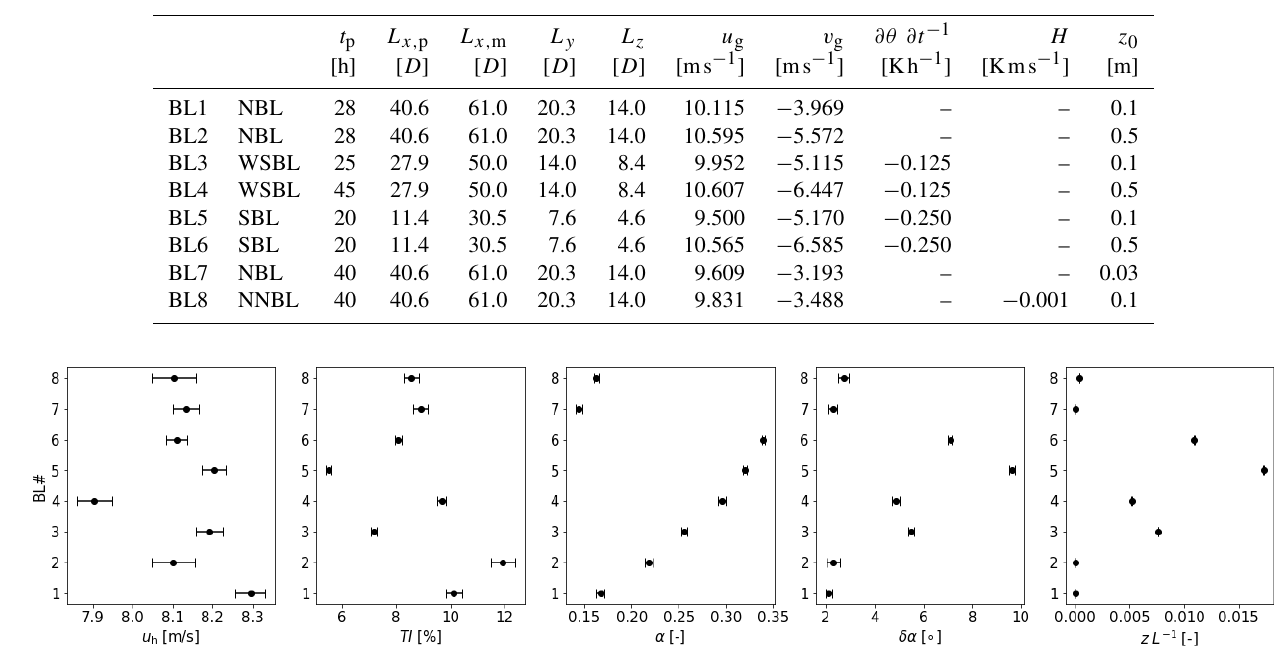
Table 1. Summary of simulation parameters and classification into neutral (NBL), near-neutral (NNBL), weakly stable (WSBL) and stable (SBL) boundary layers. The size ( L x, p ,L y ,L z ) of the domains is normalized by the rotor diameter ( D = 126m). All parameters are identical in precursor and main simulations, except for the domain size, which is extended in the streamwise direction ( L x, m ); t p is the simulated time of the precursor run, u g and v g the geostrophic wind, ∂θ∂t − 1 the heating rate, H the sensible heat flux, and z 0 the surface roughness length.